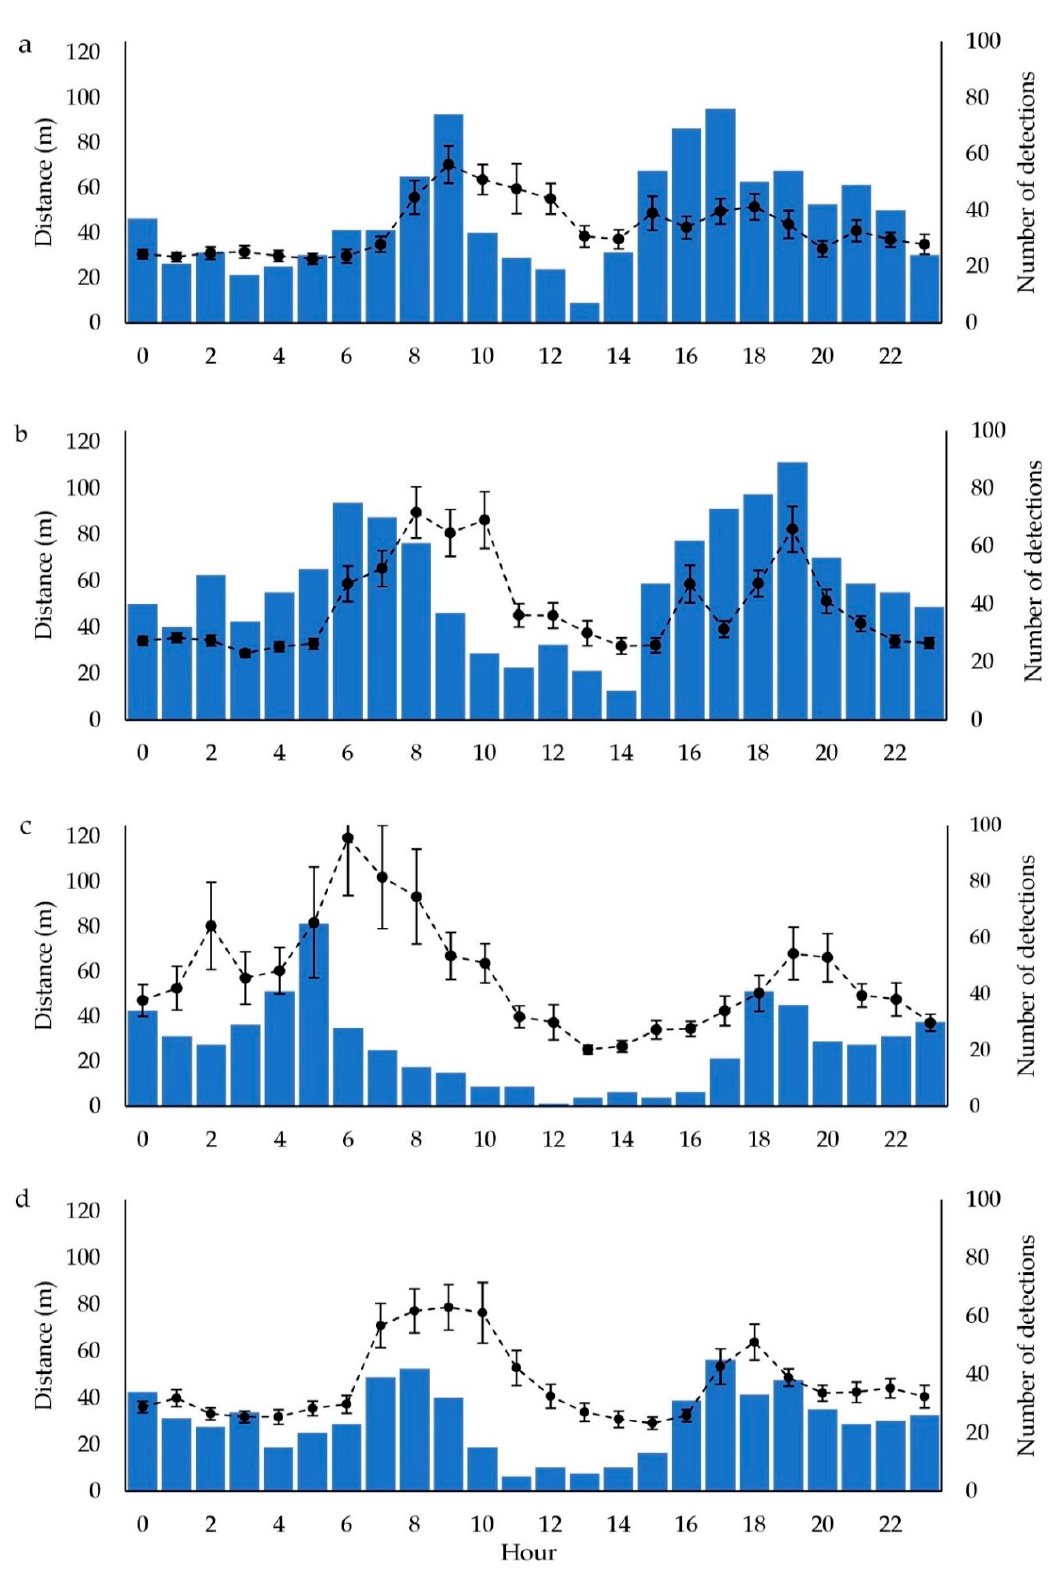
Figure 6. Average total distance moved per hour for the kangaroos surviving for the duration of the project (line plot with standard error bars and left axis) and number of single detections of resident kangaroos for each camera within each hour from the camera array (bars and right axis) for ( a ) winter, ( b ) spring, ( c ) summer and ( d ) autumn.